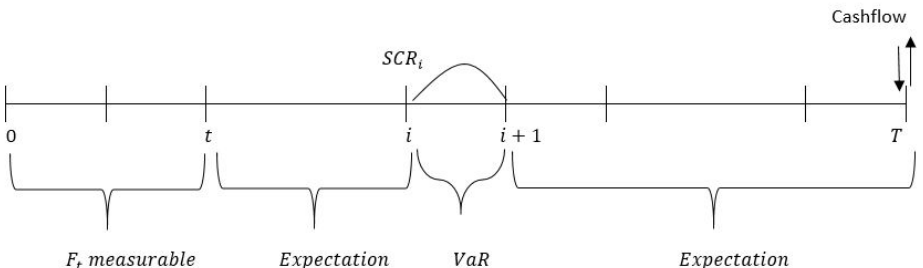
Figure 5. Computation of the successive SCR i at any time t in our